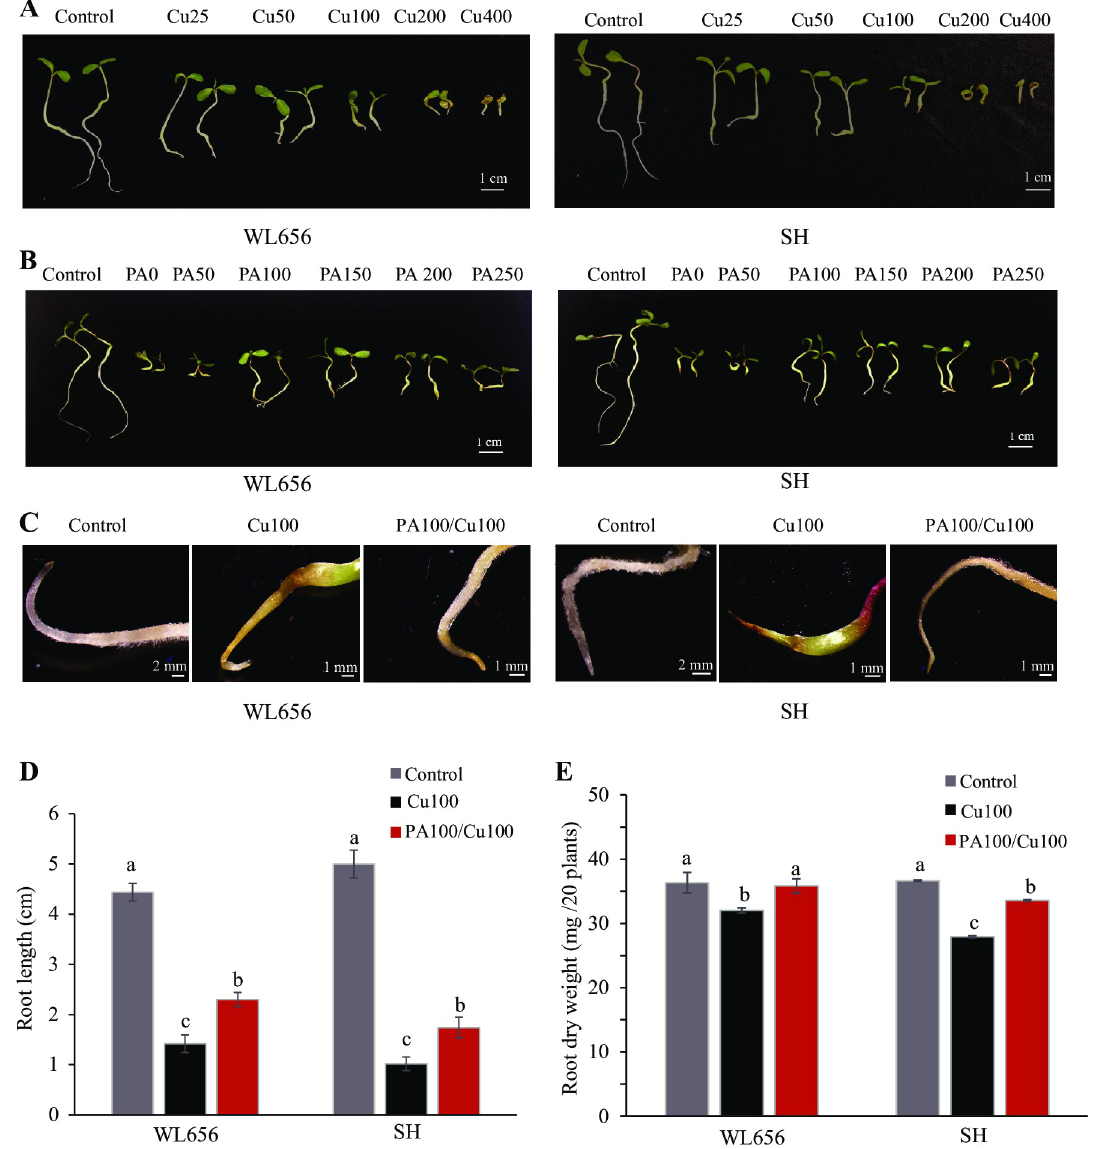
Fig 1. Proanthocyanidins (PAs) improved alfalfa seedling growth under excess Cu conditions. (A) The effect of different concentrations of Cu on seedling growth. (B) The effect of different concentrations of PA pretreatment on seedling growth with excess Cu treatment. PAs alleviated Cu toxicity on root status (C), increased root length (D) and root dry weight (E) under Cu stress. Cu 25, 50, 100, 200, 400 represents 25, 50, 100, 200, 400 mg L -1 CuSO 4 •5H 2 O. PA0, 50, 100, 150, 200, 250 represents 0, 50, 100, 150, 200, 250 mg L -1 PAs, respectively. Means ± SE of three biological replicates. Significant differences ( p � 0.05) were denoted by different lowercase letters.